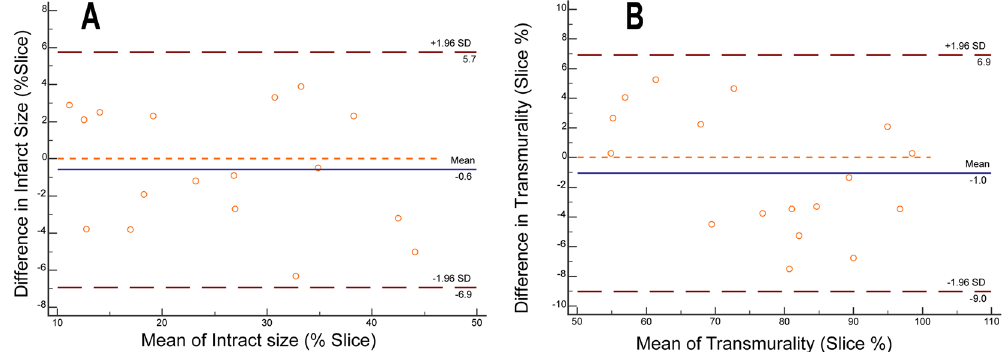
Figure 6. Bland-Altman analysis for Inter-observer reproducibility in infarct size and transmurality measurement Legend: Inter-observer reproducibility for measuring the infarct size ( A ) and transmurality ( B ). (The blue line indicates the mean of infarct size; The dashed red line indicates 95%